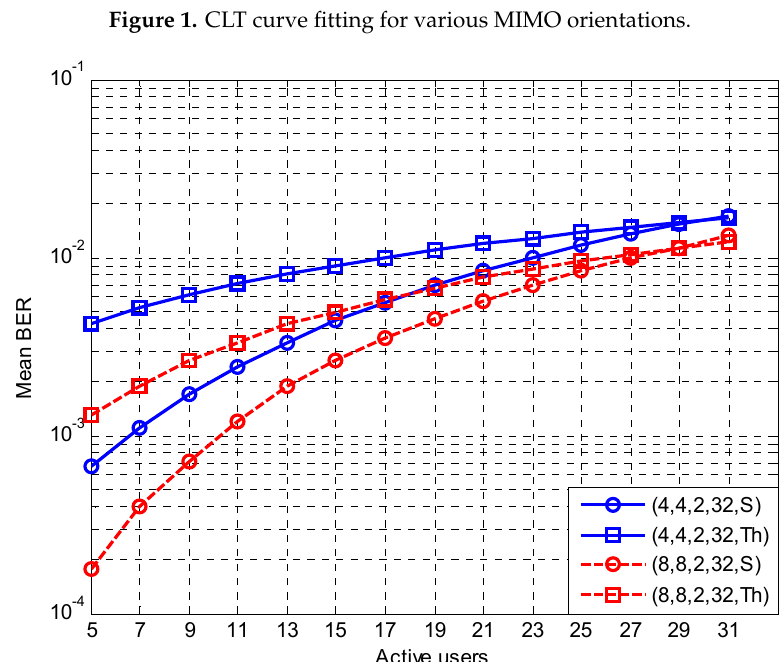
Figure 2. BER values for reduced diversity order MIMO orientations.